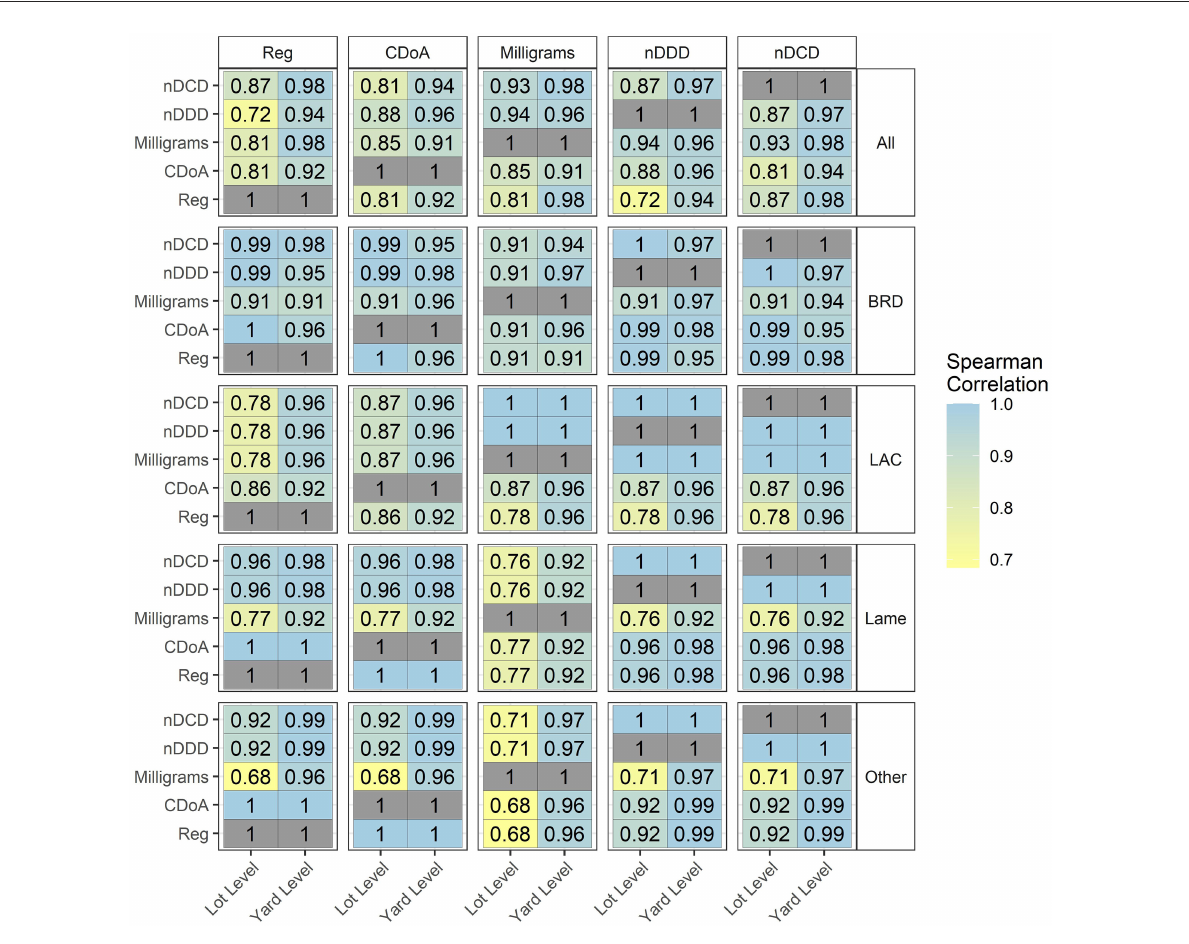
FIGURE5 Correlation of 5 numerators within use indication at the lot and feedyard (yard) levels.